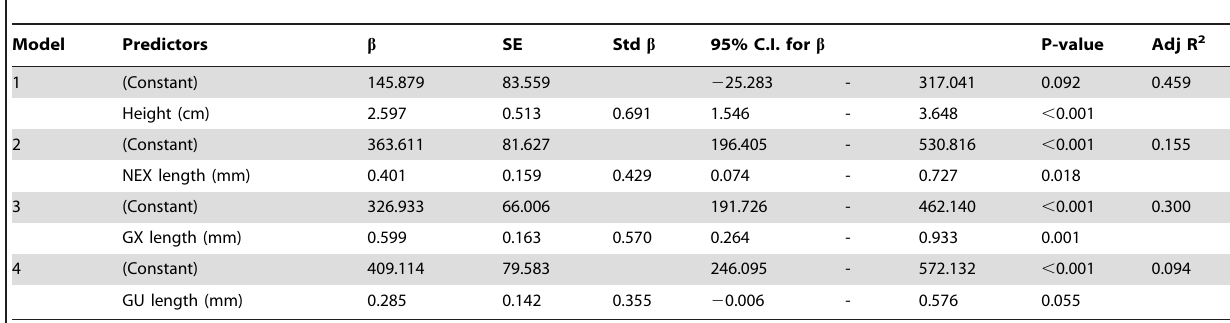
Table 2. Linear Regression Models on the NG length.